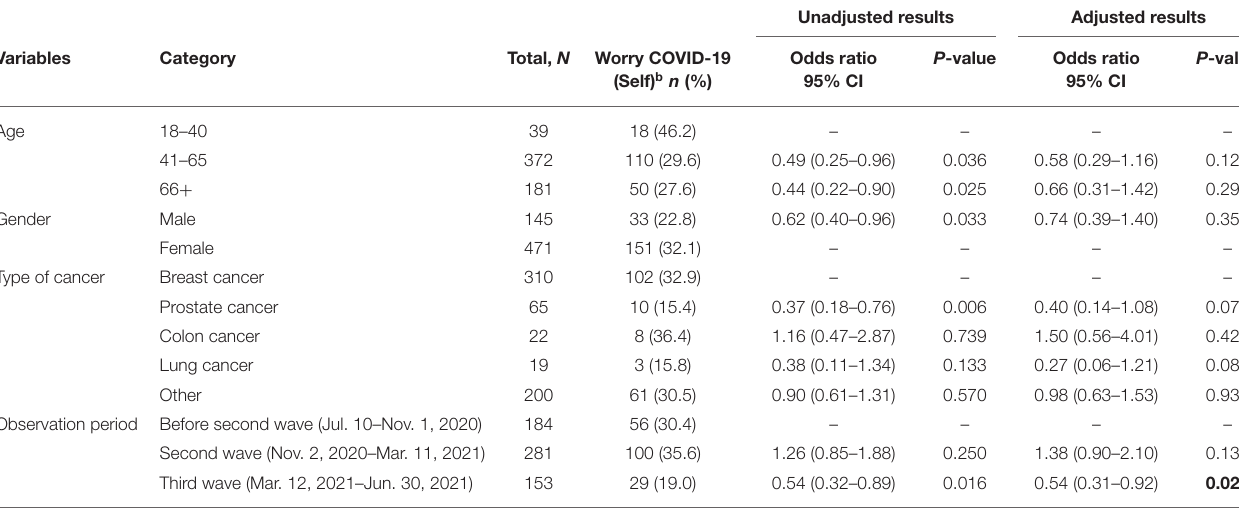
TABLE 3 | Logistic regression of associated factors for patient worry regarding being sickened or dying from COVID-19 a .